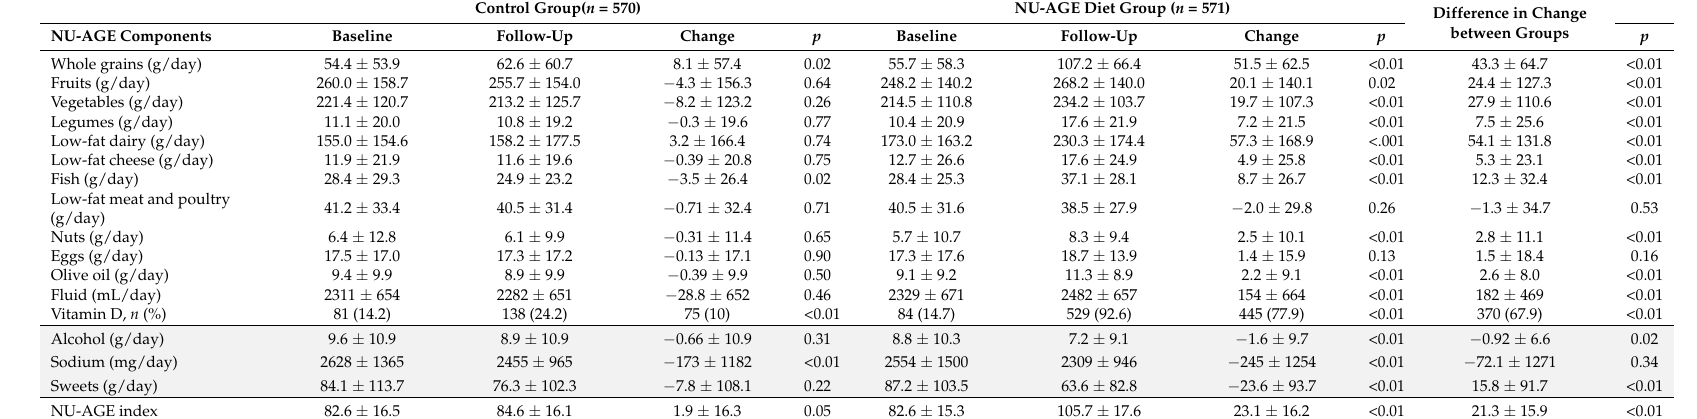
Table 3. Changes in dietary intake (g) of NU-AGE diet components during one year in 1,141 participants in the NU-AGE